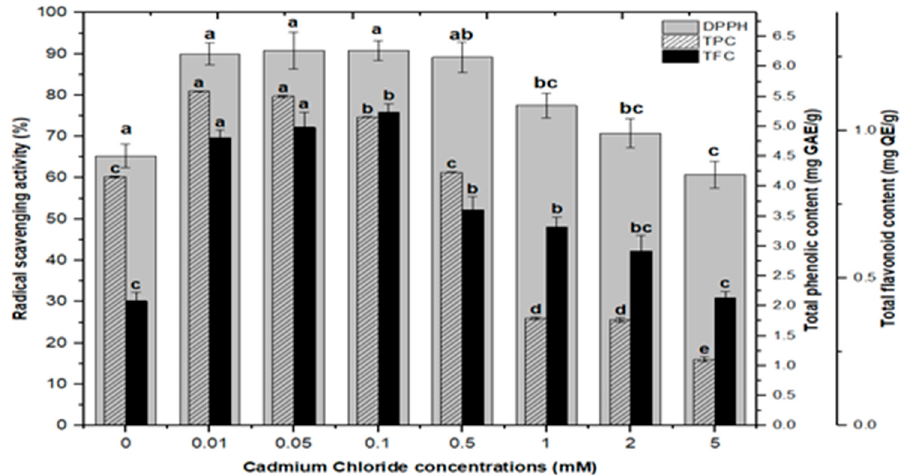
Figure 10. Radical scavenging activity (DPPH %) in comparison with total phenolic contents (TPCs) and total flavonoid contents (TFCs) (correlation ‘r’ DPPH vs. TPC = 0.727 and DPPH vs. TFC = 0.925) in F. indica callus cultures elicited with seven different concentrations of cadmium chloride along with control. Bars labeled with different letters (LSD values) exhibit significant variation ( α < 0.05). Highest superoxide dismutase (SOD: 0.088 nM/min/mg FW) and peroxidase enzyme activities (POD: 2.372 nM/min/mg FW) were recorded in culture with AlCl 3 elicitation (concentrations of 0.1 mM), respectively, in comparison with the control: SOD: 0.025 and POD: 1.69 nM/min/mg FW (Figure 11). Similarly, the antioxidant enzyme activ-